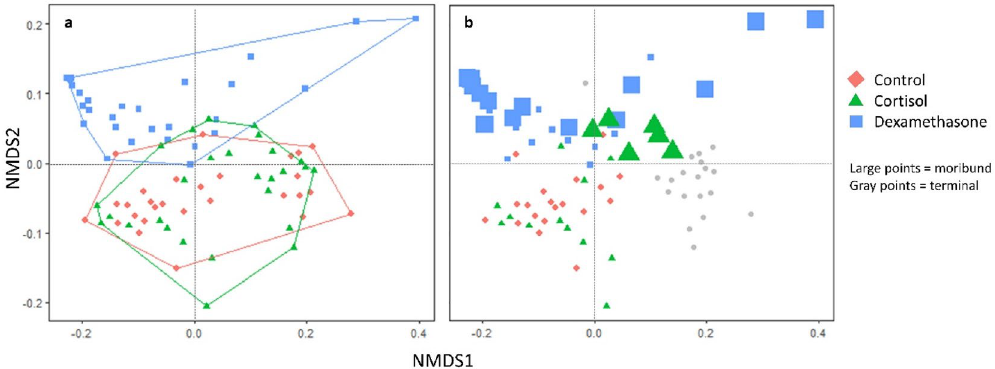
Figure 2. Nonmetric multidimensional scaling of weighted unifrac distances among juvenile gut microbiome samples. ( a ) Beta diversity differed significantly between all treatment groups based on PERMANOVA, while beta dispersion did not differ. ( b ) Beta diversity associated with subsequent mortality after controlling for treatment and tank. Grey points denote terminal